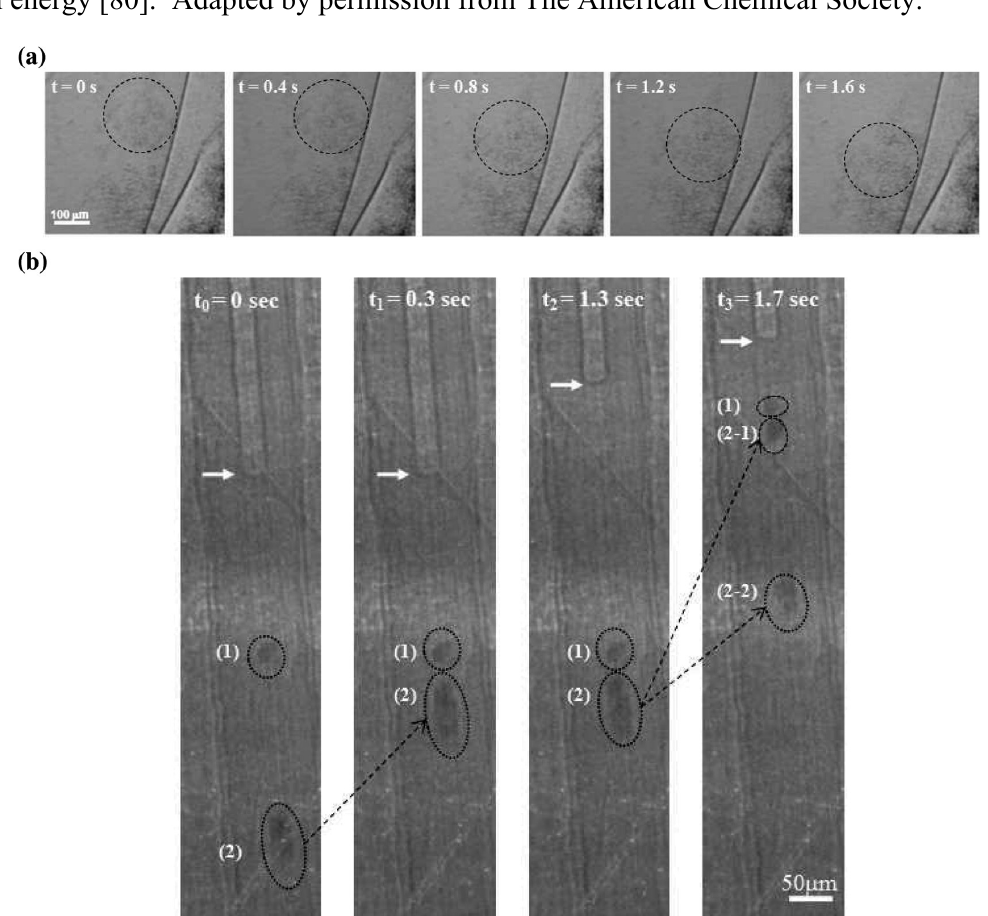
Figure 10(a) displays the time-dependent flow motion of the concentration-controlled hydrophilically surface-modified AuNPs in water caused by gravity [80]. The images are consecutively captured by synchrotron X-ray at a speed of 25 frames per second. Time-resolved images are captured through the Kapton window covering a sample holder during the designed time. When the concentration of AuNP increases to 2.4 × 10 19 AuNPs/m 3 , the dynamic images of AuNP movement are obtained. Figure 10. Application of AuNPs to the visualization of fluid dynamics in a living organism. ( a ) Time-dependent flow motions of the concentration-controlled hydrophilic AuNP aqueous solution captured by synchrotron X-ray imaging. ( b ) Four consecutive images showing the uptake and transport of hydrophilic AuNPs inside the xylem vessels of a rice leaf sheath visualized by synchrotron X-ray imaging. The arrow indicates the meniscus between water and air. (1) and (2) are initial positions of hydrophilic AuNP clusters in the sap. At t = 0 s and t = 0.3 s, only cluster (2) moves upward. At t = 1.3 s 0 0 0 = 1.7 s, cluster (1) moves up, cluster (2) is simultaneously separated into two distinct and t 0 clusters (2 − 1) and (2 − 2) with different velocity. The images are captured consecutively by the synchrotron X-ray source using a bending magnet. X-rays with a peak energy of 20.3 keV (8–30 keV range) are applied as a function of time without monochromator to obtain high energy [80]. Adapted by permission from The American Chemical